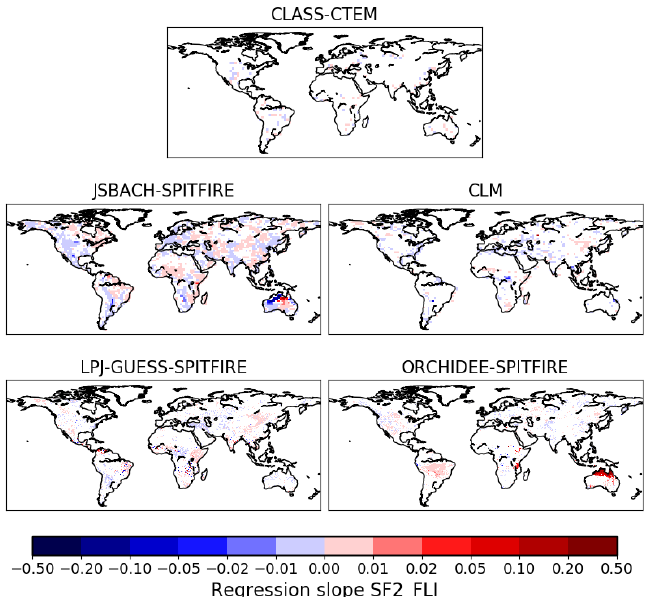
Figure A6. Spatial distribution or regression slopes for the difference between the baseline experiment SF1 and the sensitivity experiment SF2_FLI (SF1–SF2_FLI; see Table 1) over